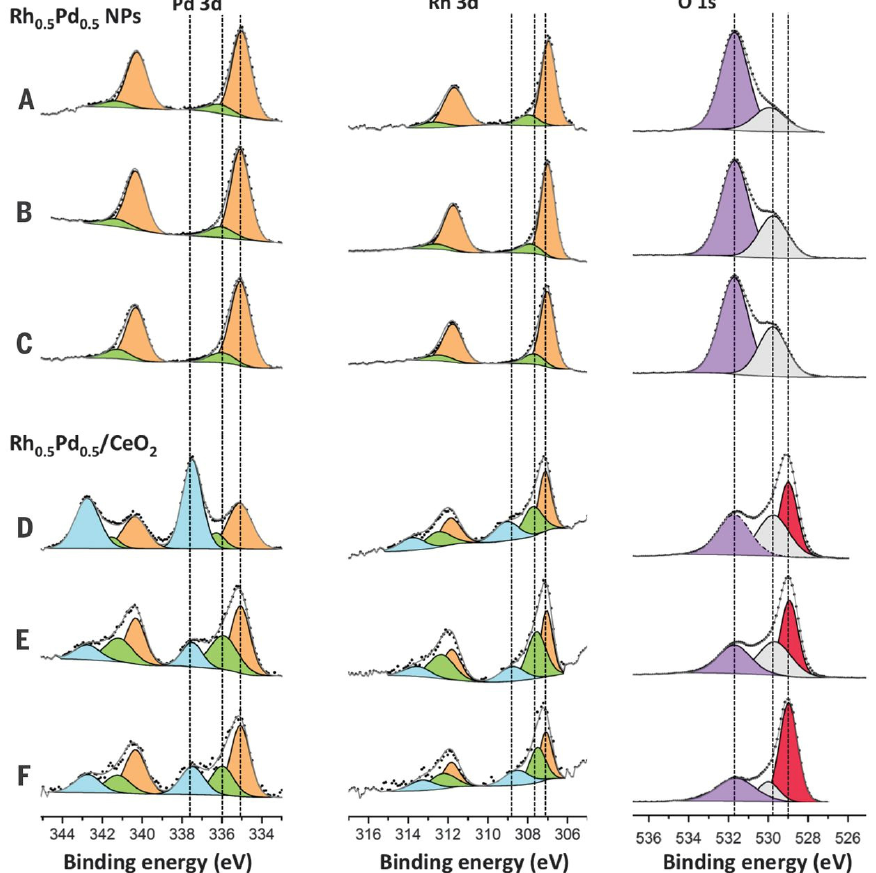
Figure 5. NAP-XPS spectra of Pd 3d, Rh 3d and O 1s recorded over model Rh 0.5 Pd 0.5 NPs ( A to C ) and Rh 0.5 Pd 0.5 / CeO 2 catalyst ( D to F ) under steam reforming of ethanol (SRE) conditions at 823 K. The photon energies used were 670 eV ( A and D ), 875 eV ( B and E ) and 1150 eV ( C and F ). Reprinted with permission from [68], copyright 2014, Science.